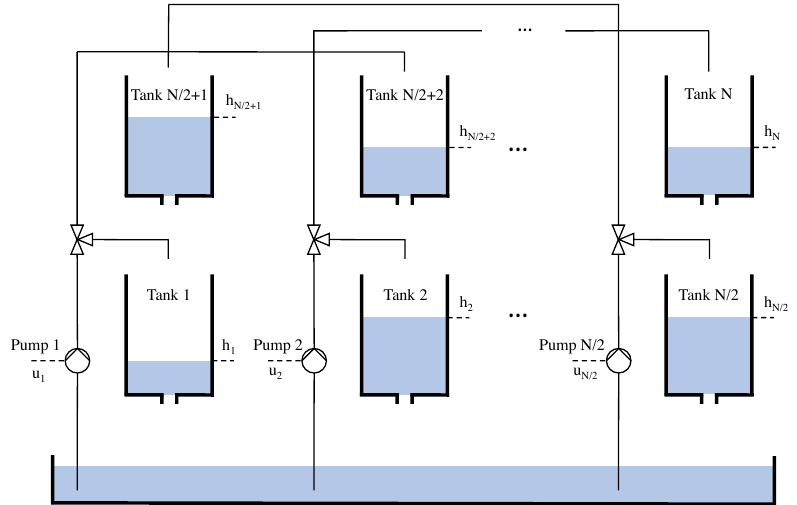
Figure 1. Schematic of the N tanks